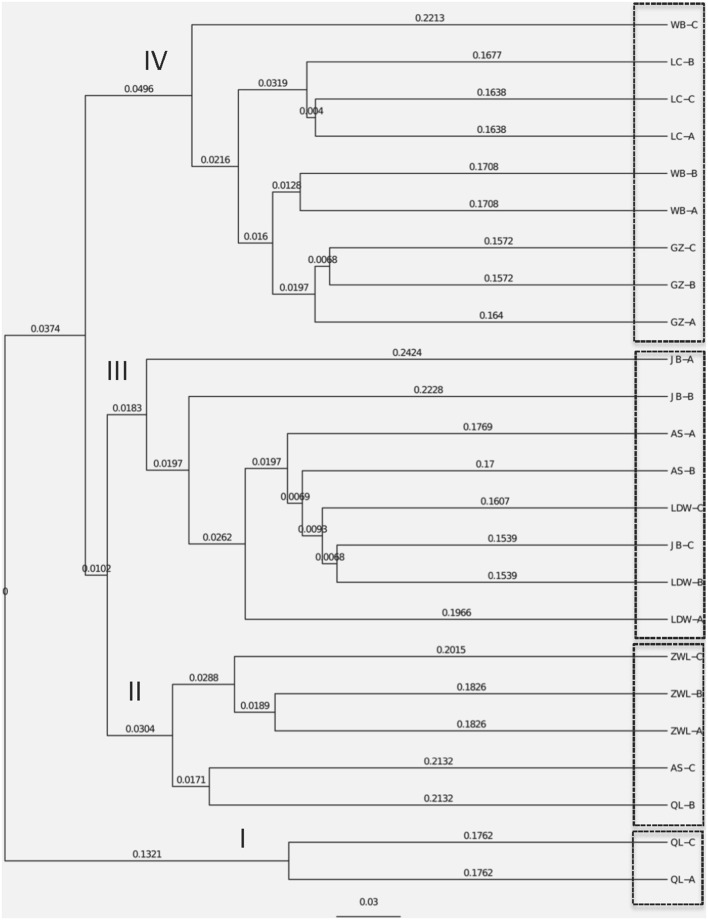
Cluster analysis of soil bacterial structure based on the dissimilarity matrix of the NMDS analysis. OL and ZWL represent locations from Qingling and Ziwuling mountain forests, respectively; LDW represents sites from grassland Liandaowan township; GZ, LC, and WB refer farming areas from three Loess tablelands–Guanzhong, Luanchuan, and Weibei, respectively. AS and JB from regions of forest steppes (Ansai county) and dessert steppes (Jingbian county). The codes of A, B, and C after the above-mentioned site abbreviations represent various biological replicates at landscape scales.